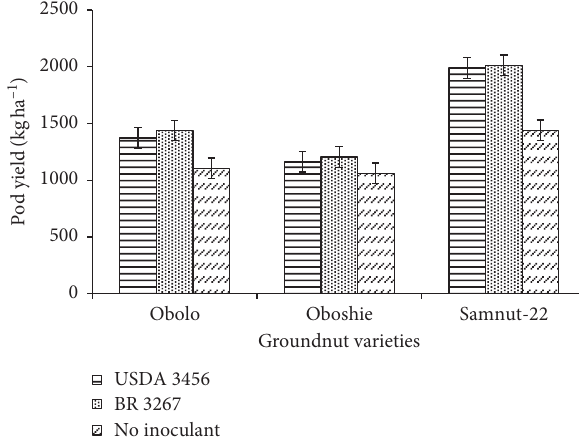
Figure 2: Pod yield responses of three groundnut genotypes to rhizobium inoculation (the bars represent LSD at P < 0.05).